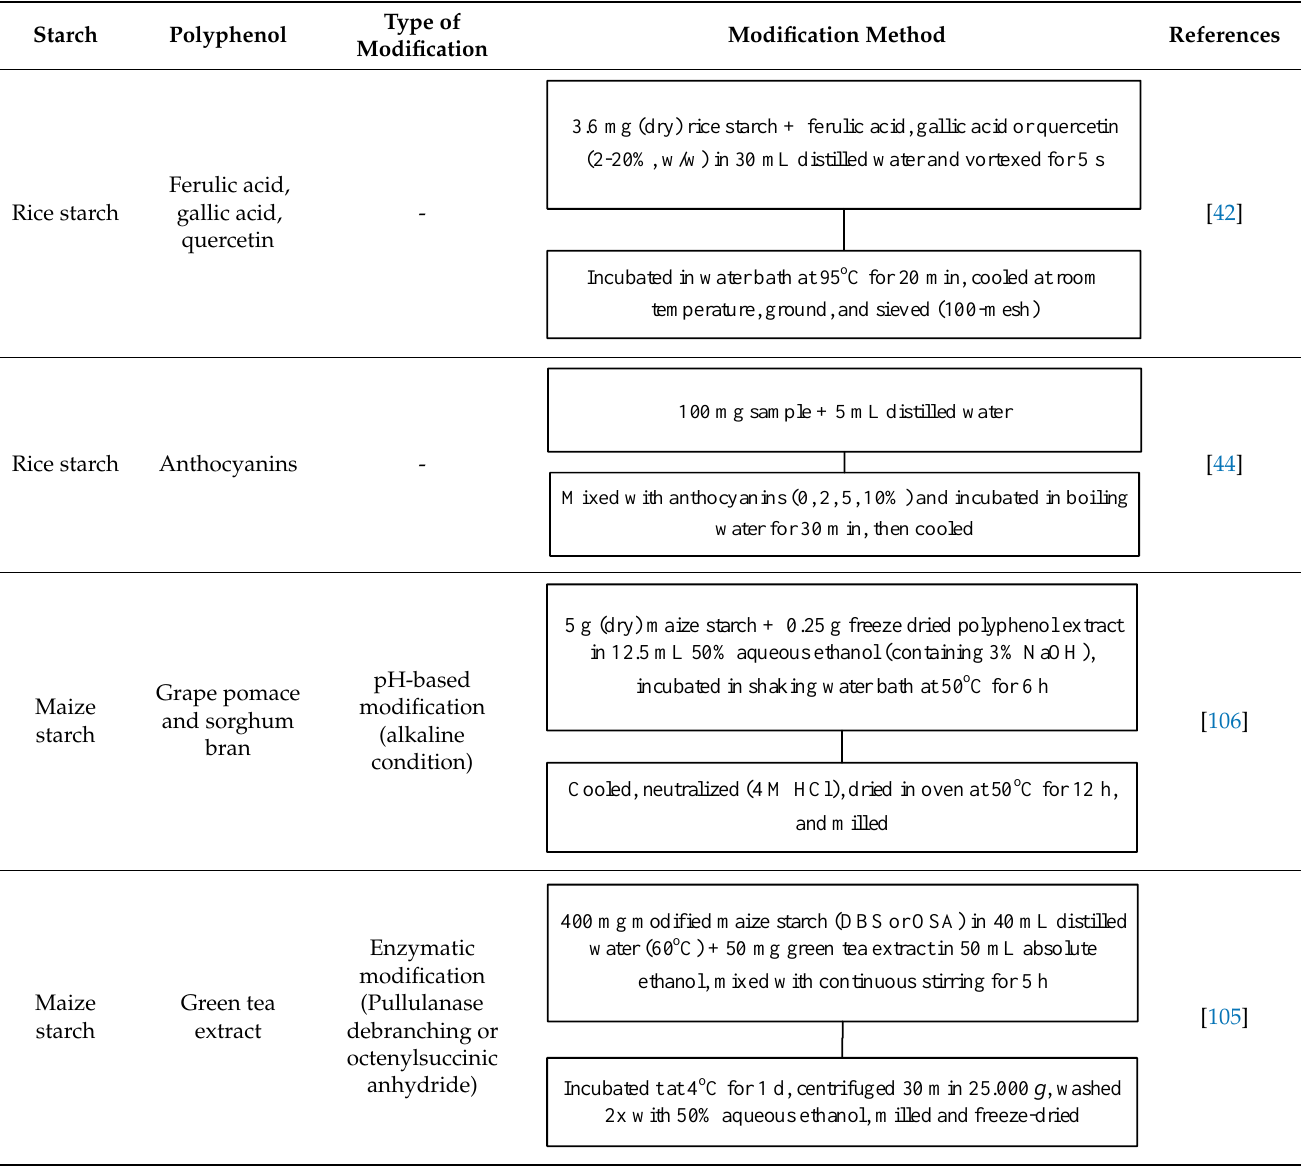
100 mg sample + 5 mL distilled water